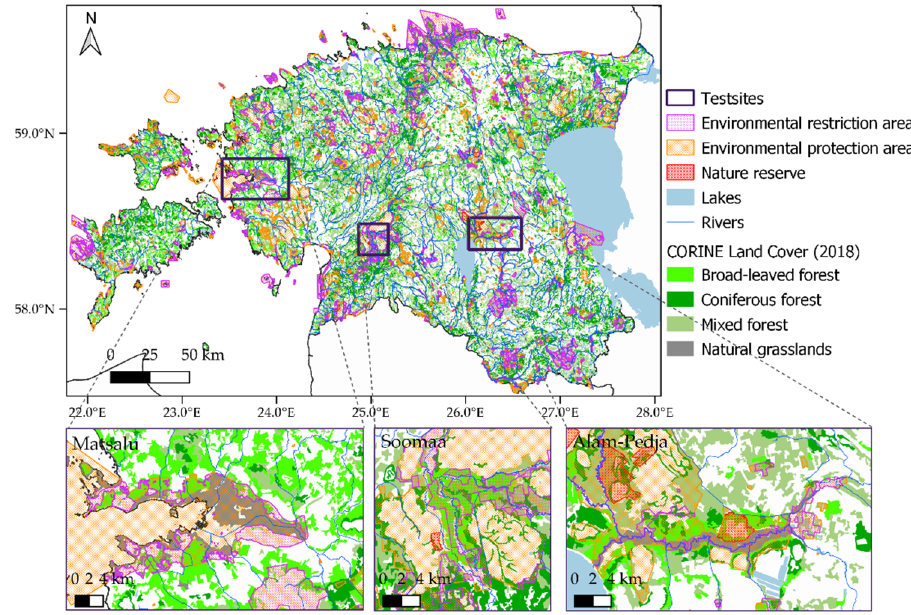
Figure 1. Location of the test sites. Table 1. Share of natural grassland and forest types at study sites according to CLC